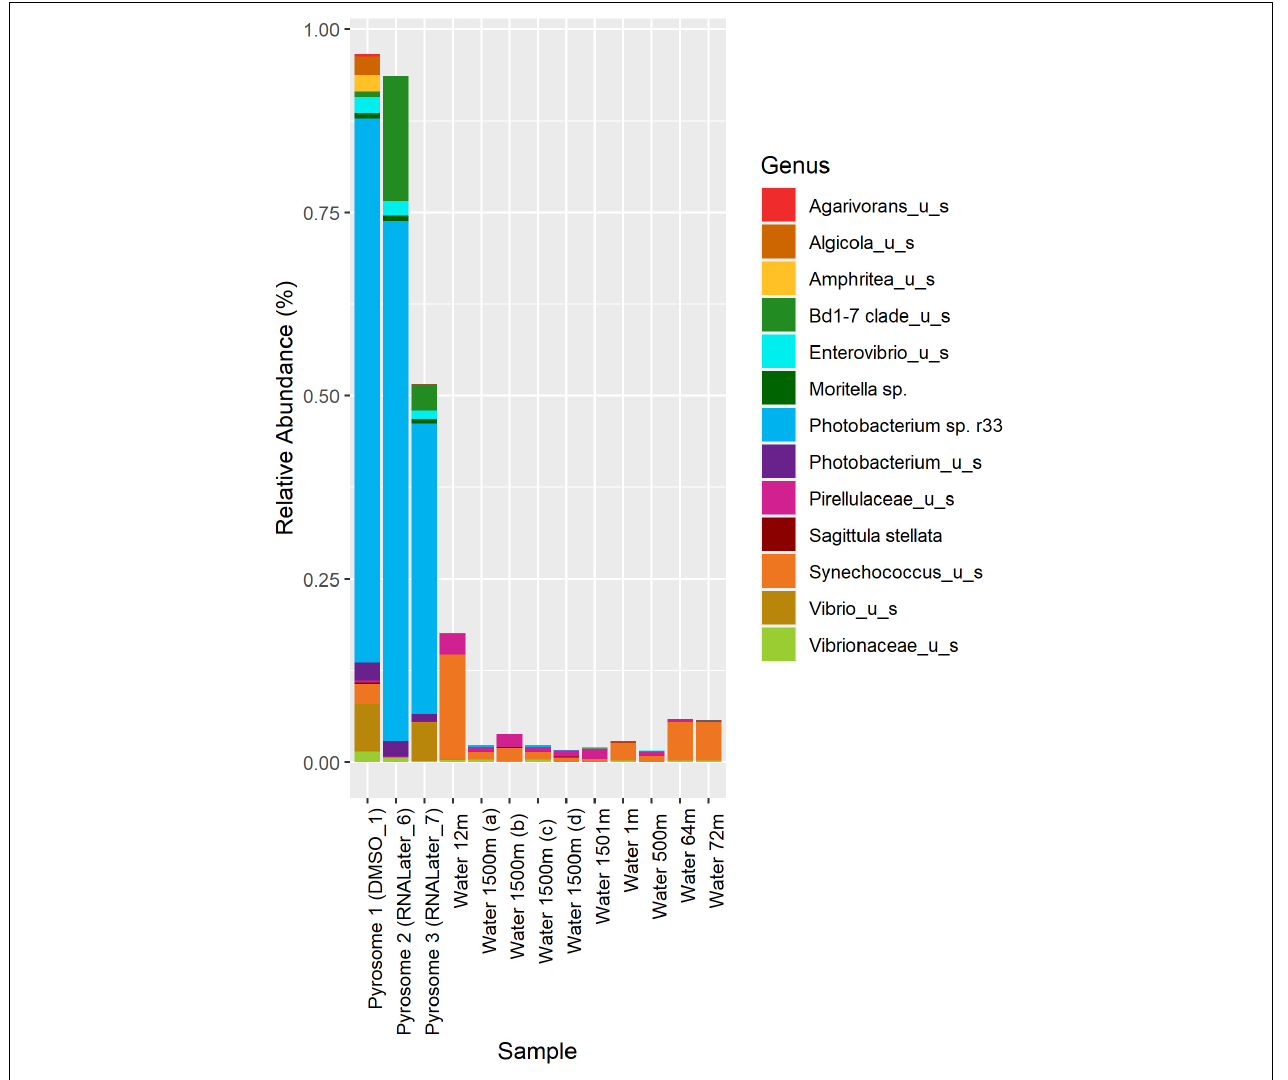
FIGURE 2 | Relative abundance of the top 13 bacterial taxa across different samples. Columns 1–3 represent microbiomes derived from tunicate specimens preserved under different conditions. The next 10 samples show bacterial distributions in seawater samples from the same location (Easson and Lopez,